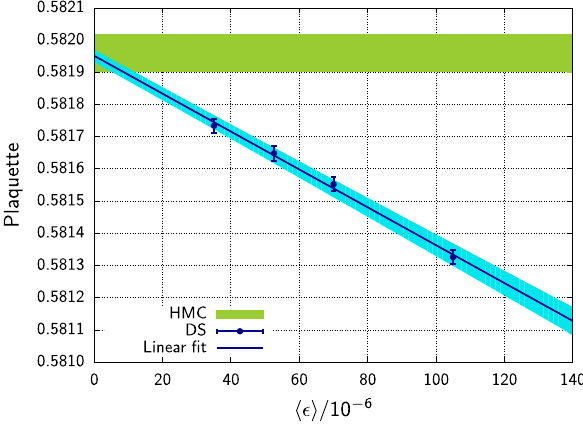
Fig. 14 The plaquette at zero chemical potential as a function of the average Langevin step size. The green band represents the value obtained from a HMC simulation and the blue region depicts the error band from the linear fit to the Langevin